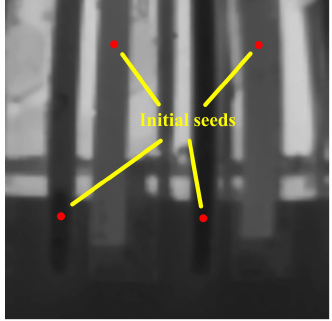
Figure 8. Illustration of all initial